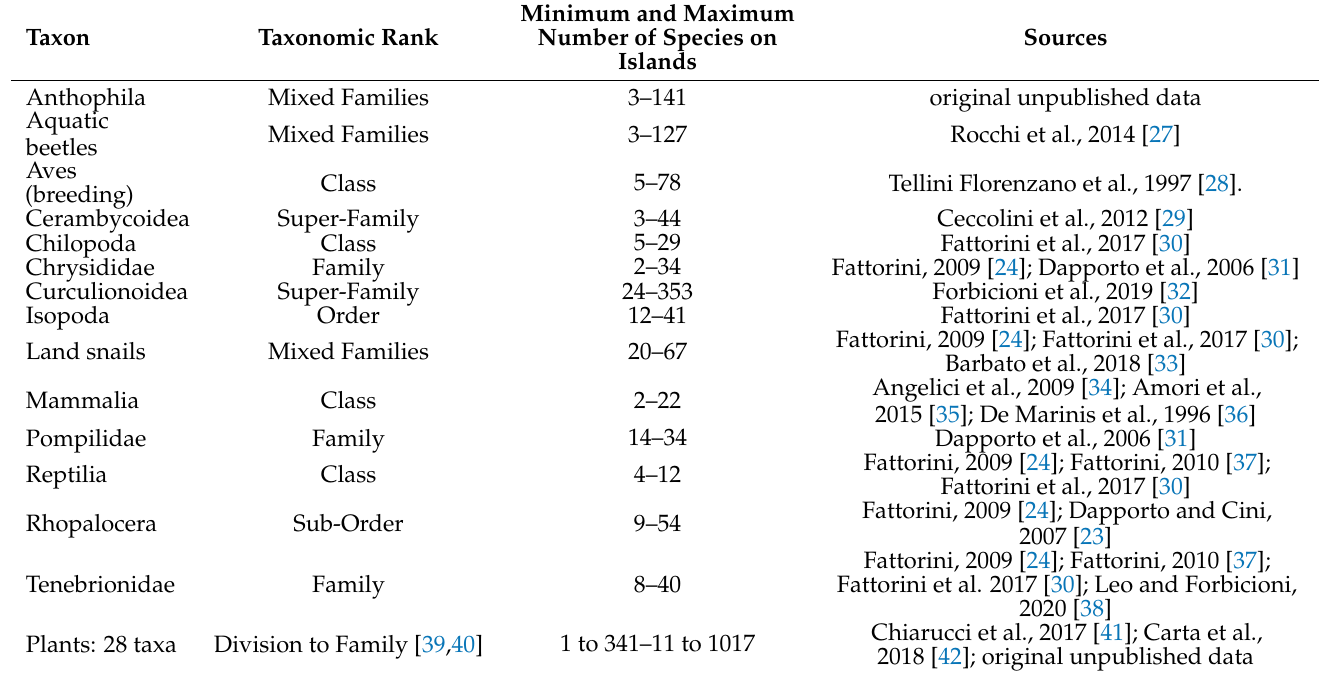
Table 1. Data sources for the analyzed taxa.